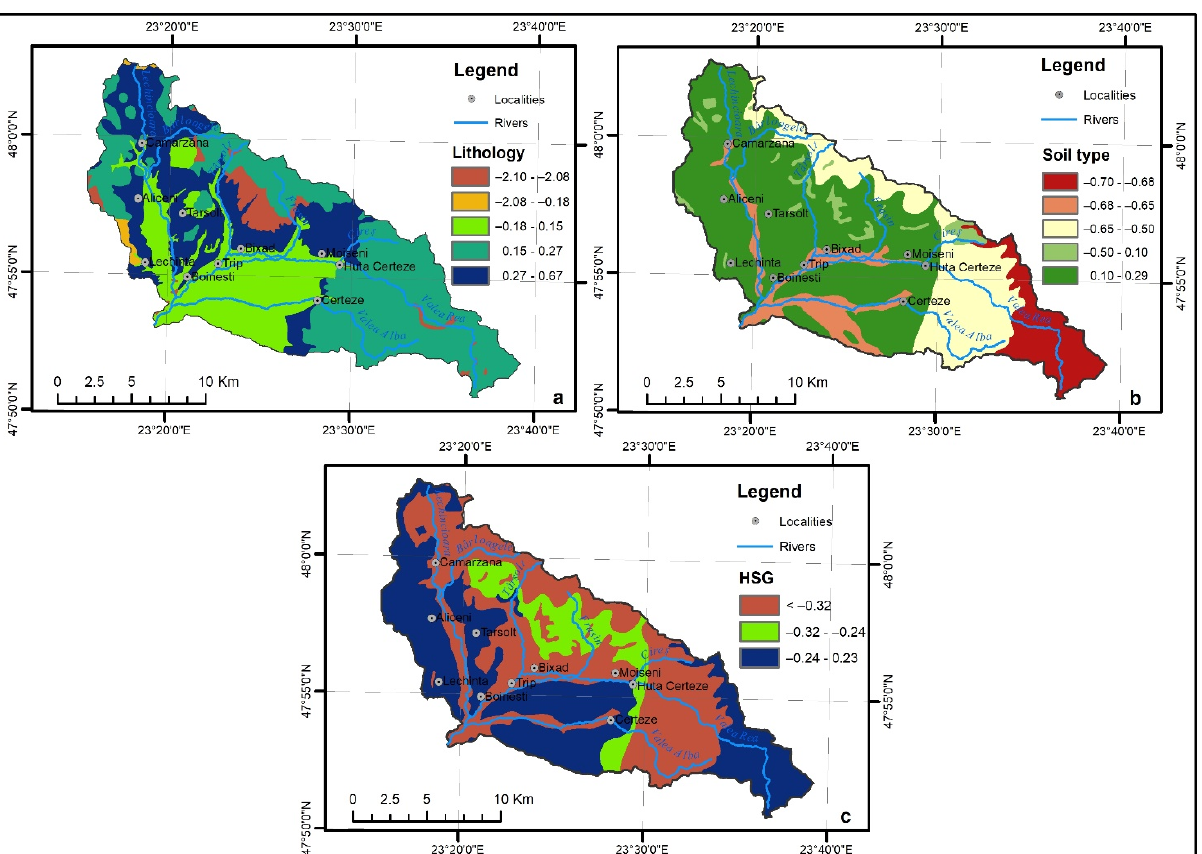
Figure 6. ( a ) Lithology, ( b ) Soil type, ( c ) Hydrologic soil